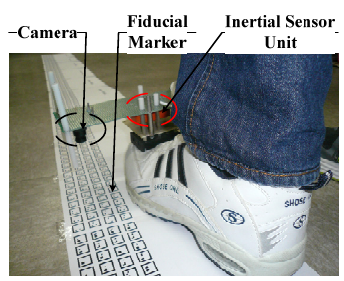
Figure 1. Gait Analysis System.